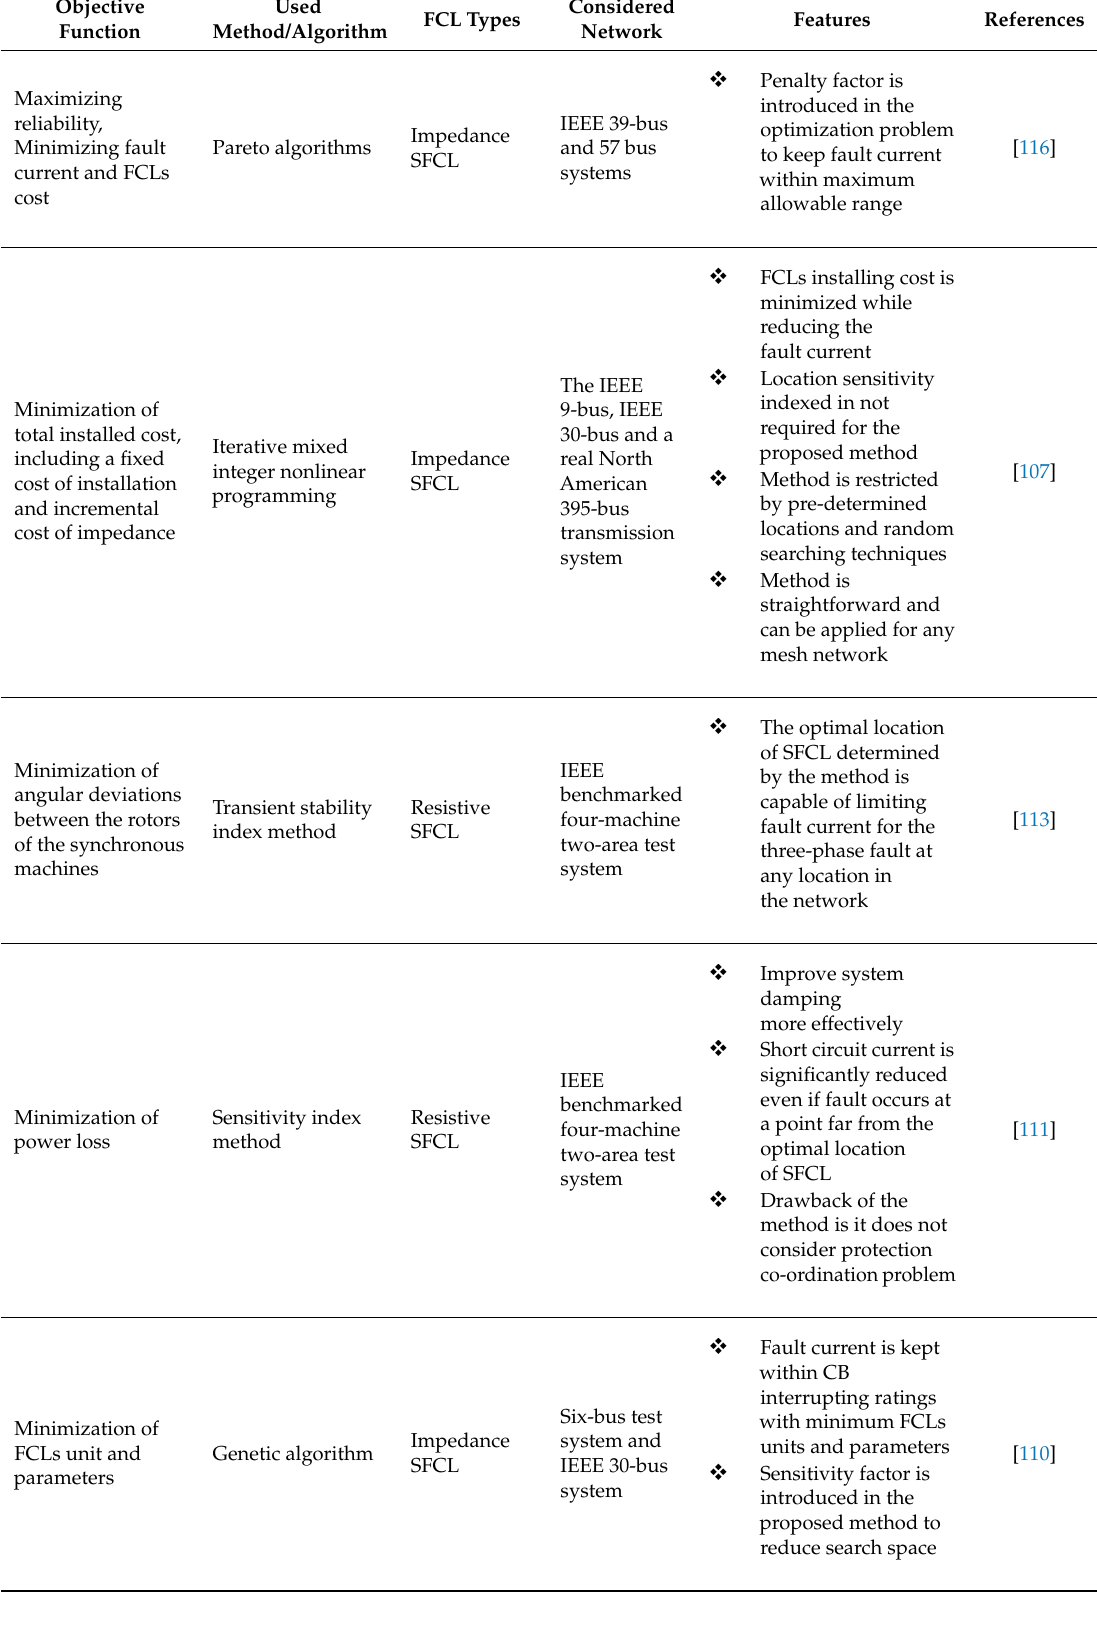
Figure 4. The phases for implementing a N-AHP in SWOT analysis.